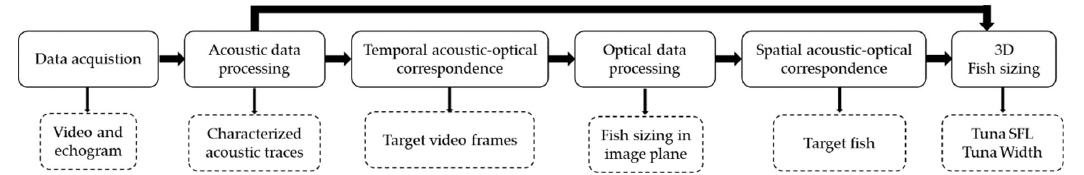
Figure 1. Top row: Sequence of processes performed automatically in our proposal; bottom row: The results of each step.